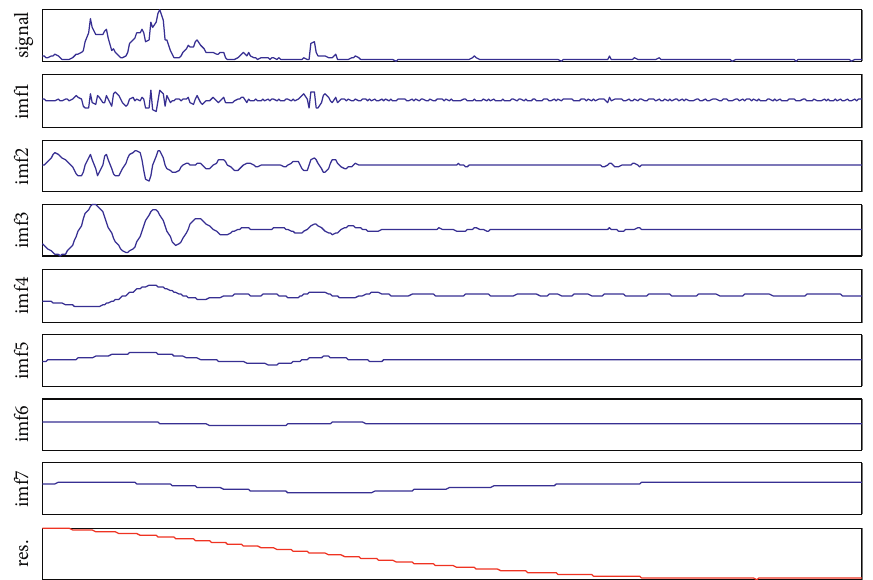
Figure 5: EMD exploded view of “Hong Kong-Macao-Zhuhai Bridge opened to traffic” nonrumor. Table 2: Correlation coefficients between intrinsic mode function (IMF) components and original time